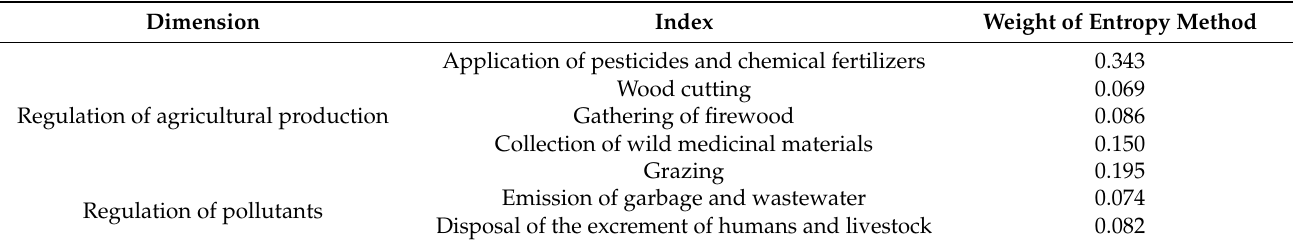
Table 3. System of measuring the regulation intensity of nature